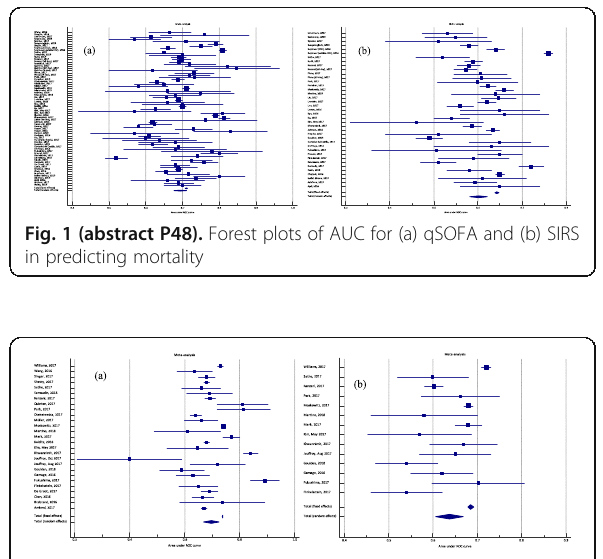
Fig. 2 (abstract P48). Forest plots of AUC for (a) qSOFA and (b) SIRS in predicting composite outcomes (organ dysfunction or admission to